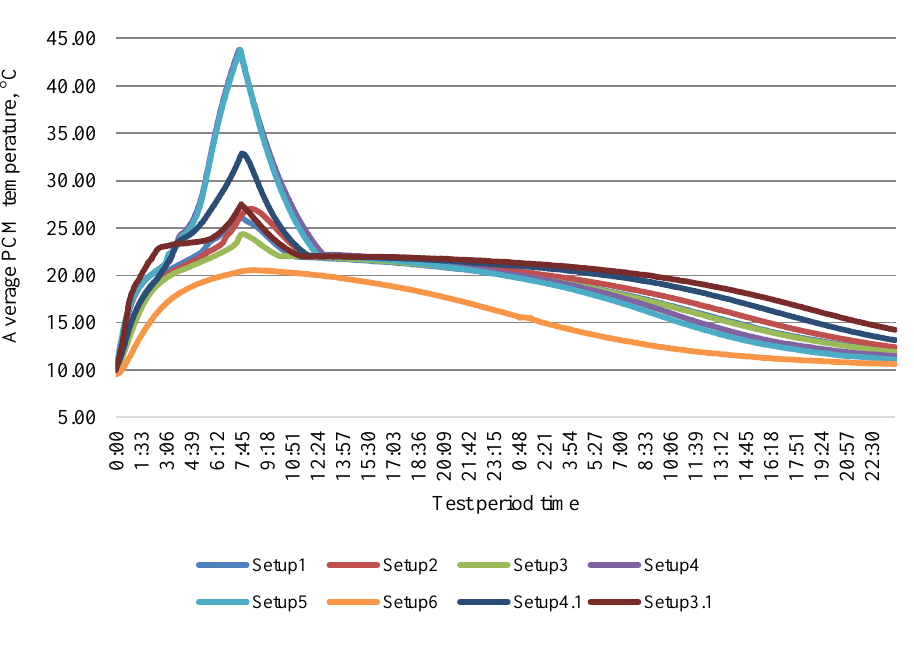
Fig. 6. Average PCM temperature in various